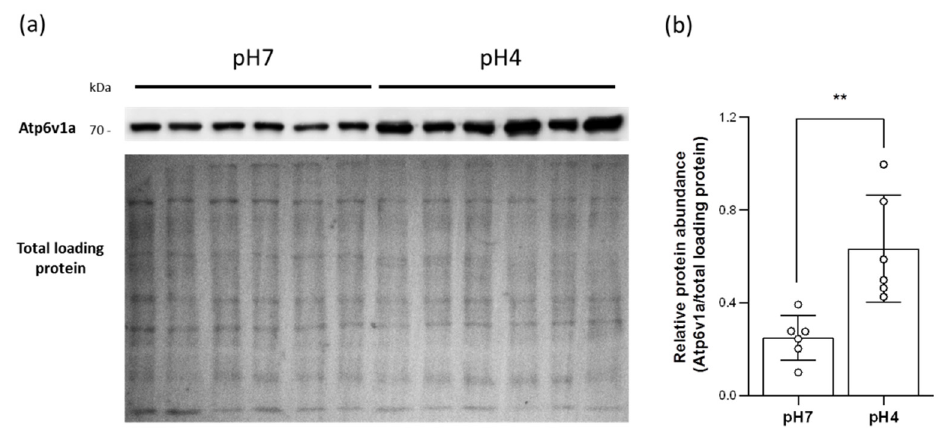
Figure 4. Effects of acid acclimation on the HA accumulation in the plasma membranes of the gills. The protein expression of HA in the branchial plasma membranes acclimated to acid environments was analyzed by Western blot. The blots showed the band with a molecular weight corresponding to Atp6v1a (approximately 70 kDa), and the PVDF membrane stained by ponceau S showed bands of total loading proteins ( a ). The protein expression of HA was quantified and normalized to total loading protein (N = 6) ( b ). Values are the mean ± SD. Student’s t -test, ** p < 0.01.